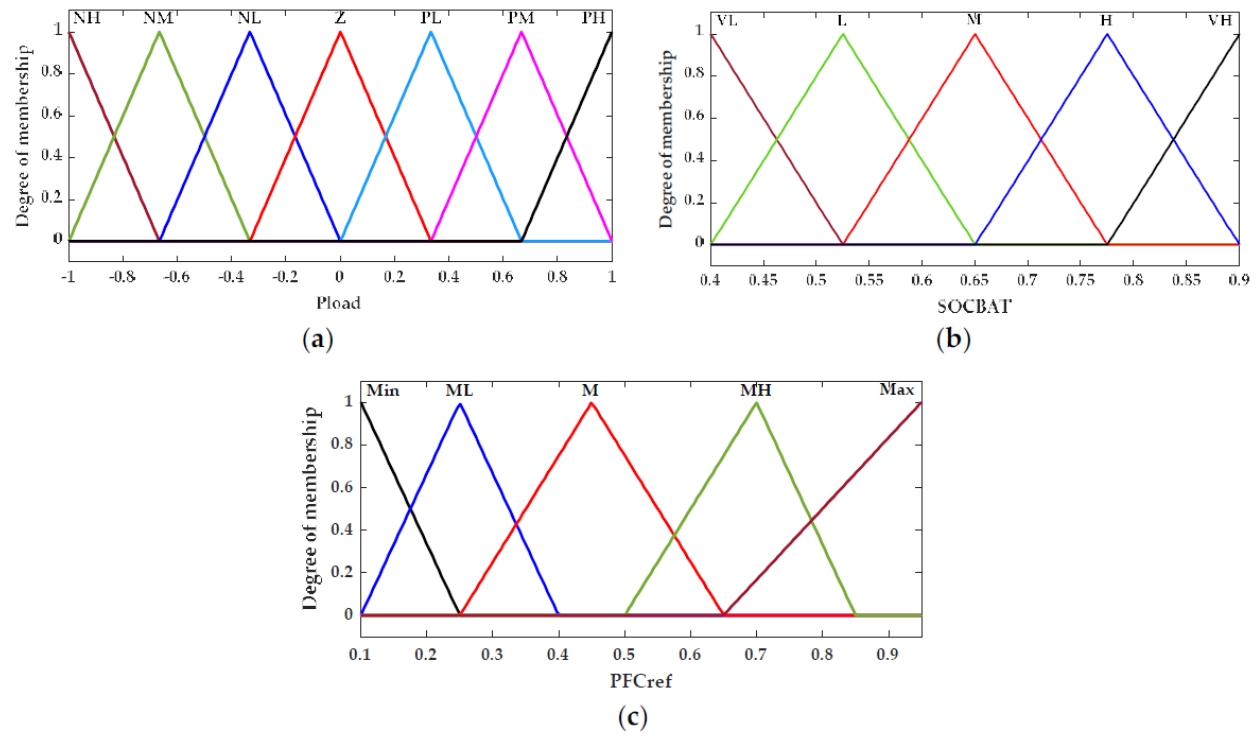
Figure 9. Inputs and output membership functions of the FLRs [15,37]. ( a ) Input variable P load ; ( b ) Input variable SOC BAT ; ( c ) Output variable P FCref . Table 4. Fuzzy rules for the inputs and output membership functions